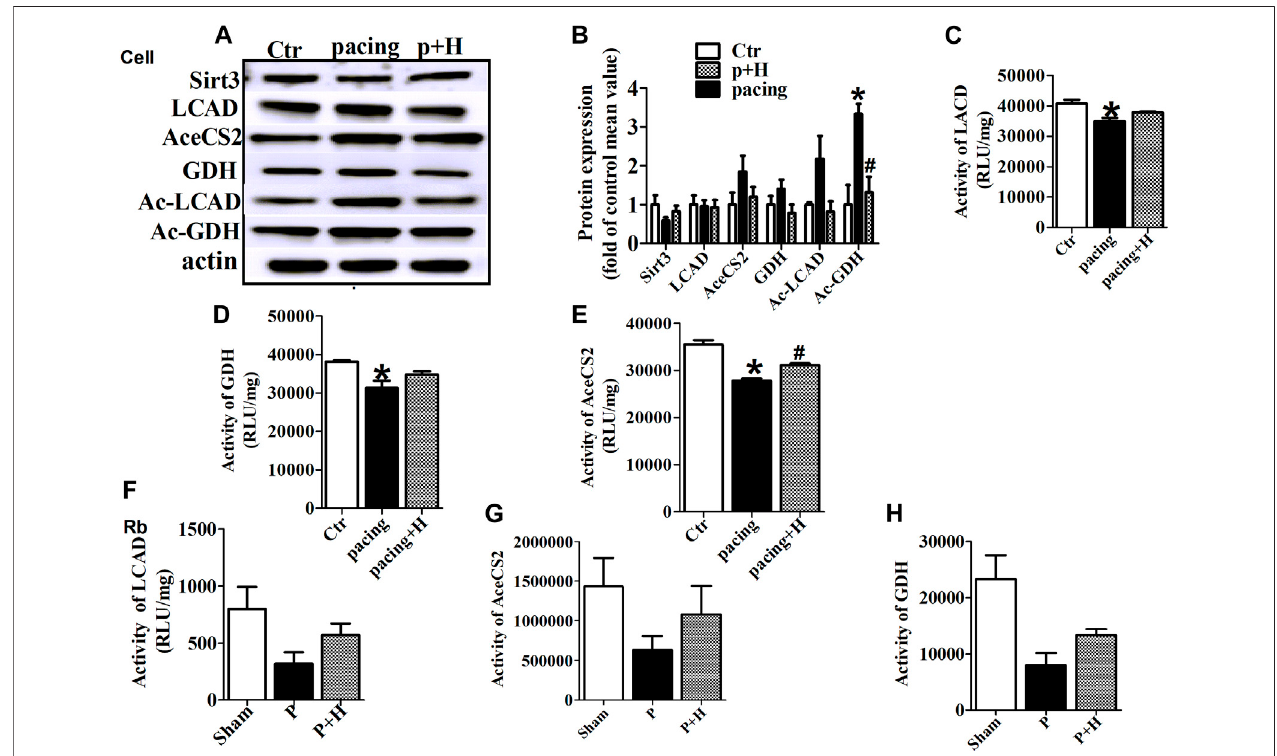
FIGURE 4 | HL inhibited abnormal expression and acetylation of key metabolic enzyme and restored the activity of these enzymes during AF. (A and B) Representative bands and statistical results of Sirt3, LCAD, AceCS2, GDH, Ac-LCAD, Ac-GDH in pacing-HL-1 cells. Data from these proteins were normalized to β - actin. (C,DandE) StatisticalresultsforactivityofLCAD,GDHandAceCS2inpacing-HL-1cells.* p < 0.05vs.shamgroup,# p < 0.05vs.pacinggroup,n=3eachgroup. (F,G and H) Statiscal results for activity of LCAD, GDH and AceCS2 in all groups of rabbits. n = 5 each group.